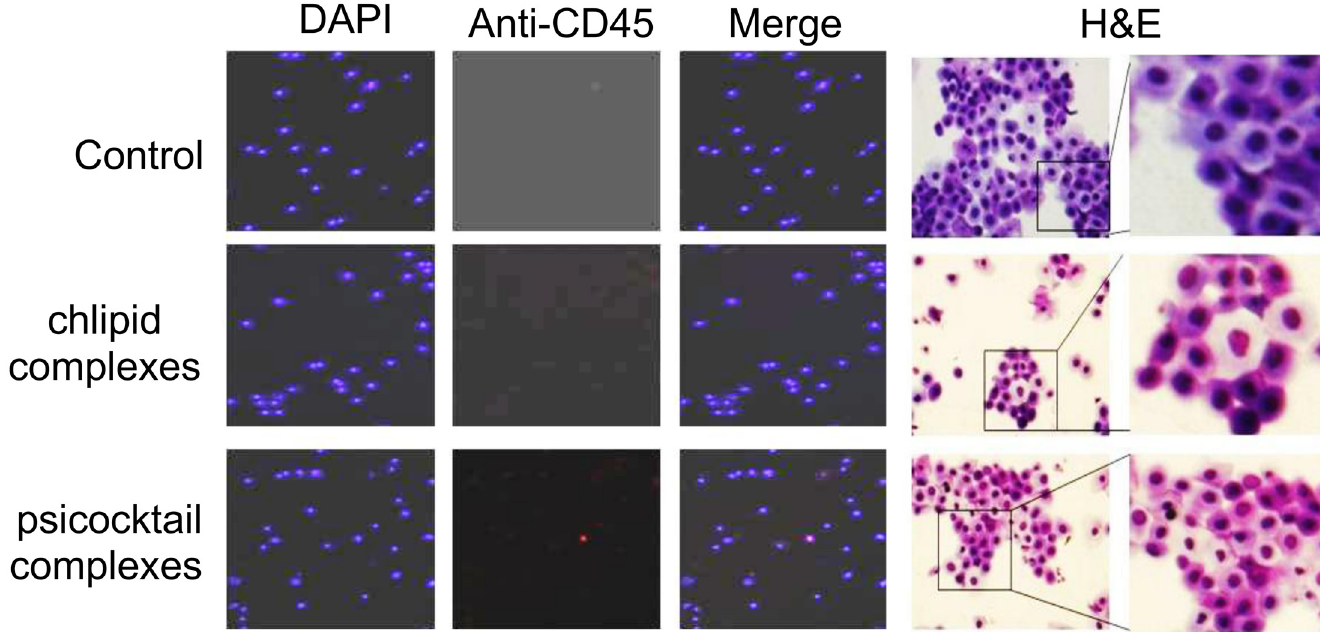
Fig 6. Safety studies in RVI model. Rabbits (n = 9) were divided into three groups and in each group (n = 3) we applied cream alone, cream mixed with chlipid nanocomplexes, or cream mixed with psicocktail chlipid nanocomplexes every day for 9 days. In the RVI model, the CVL was collected at days 11 and 20, the cells were cytospun, fixed with 4% paraformaldehyde and permeabilized using 100% methanol. The cells were later treated with anti-CD45 tagged with Alexa Fluor 555 and viewed under a fluorescence microscope. Images were taken at 100x magnification. The two panels on the right show H&E-staining of the cells from CVL of rabbits treated as described above.